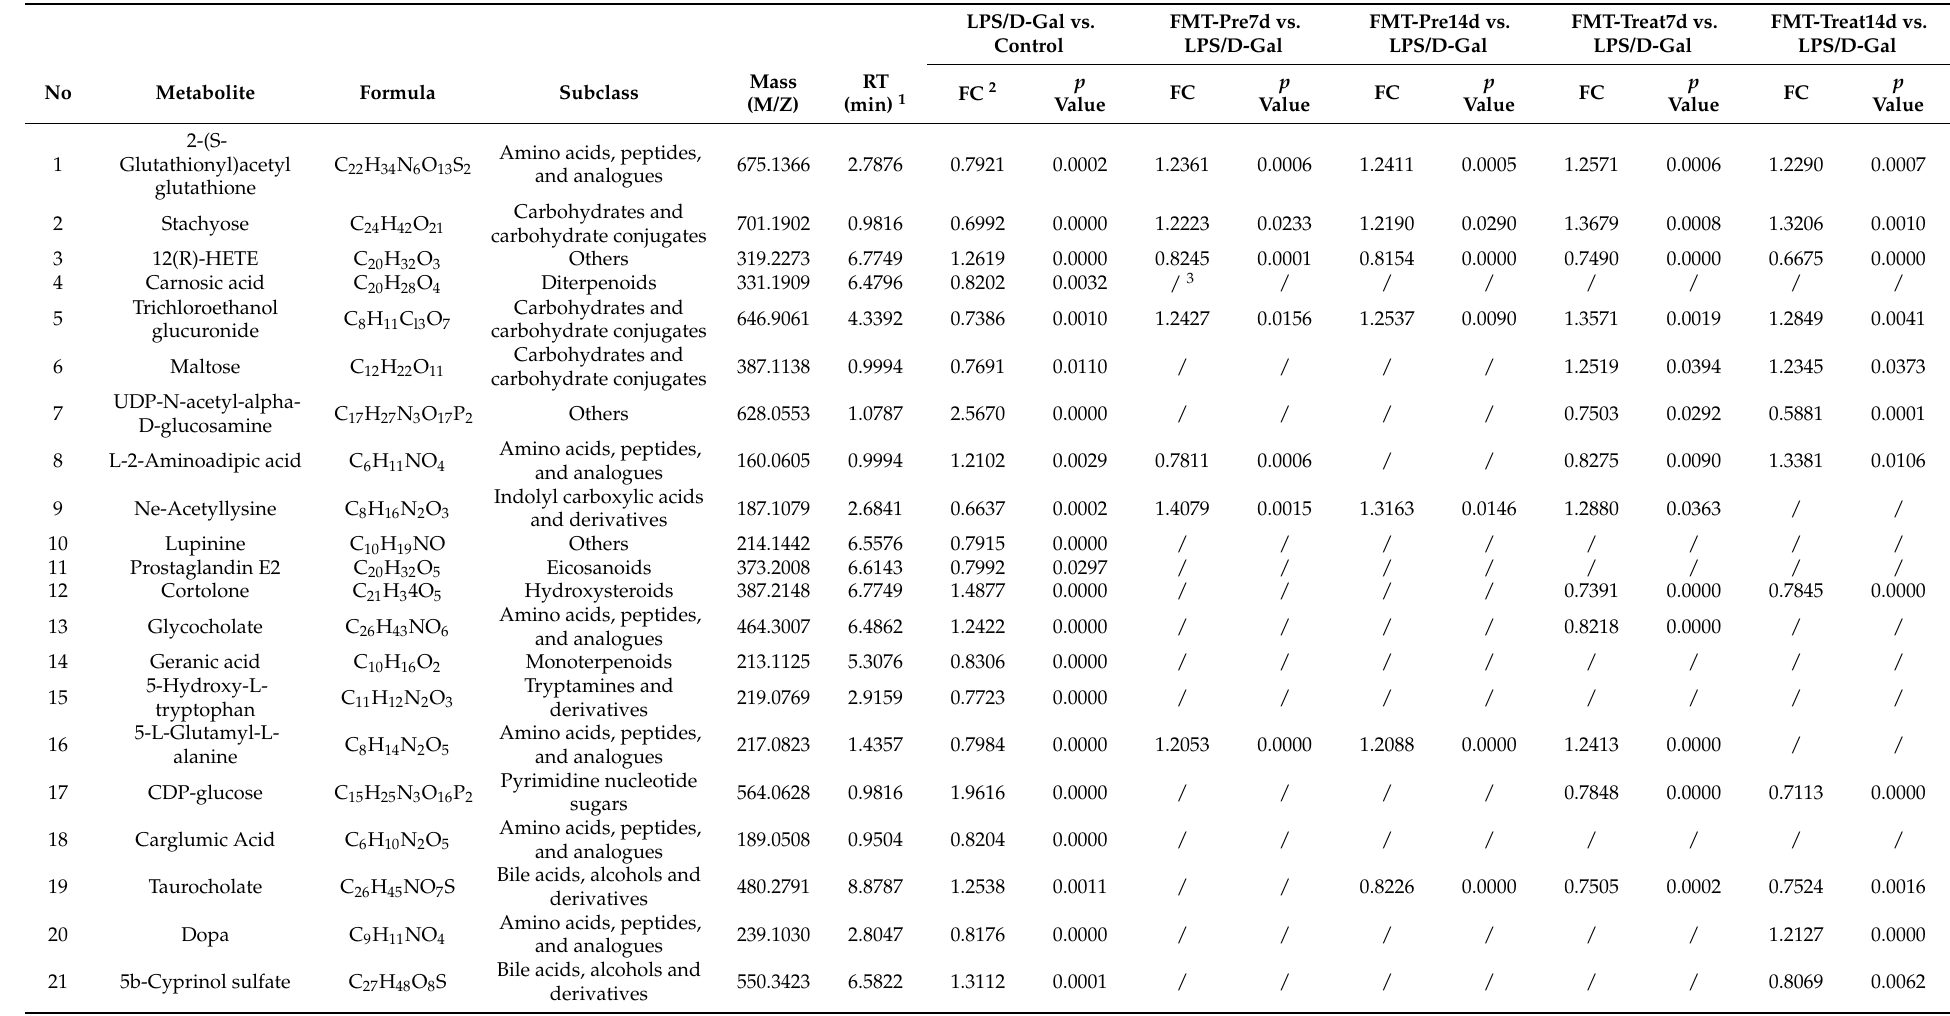
Table 1. Twenty-five metabolites with statistical differences identified based on VIP > 1 in the loading plot, FC ≤ 1.2 or FC ≤ 0.8333, p < 0.05, and with KEGG numbers.